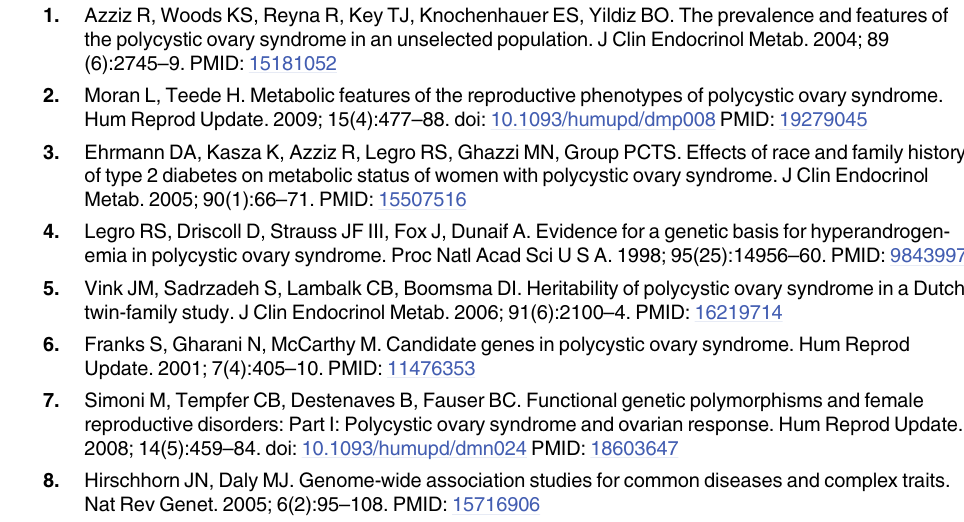
S1 Table. Significant genes within other biological pathways or gene sets associated with polycystic ovary